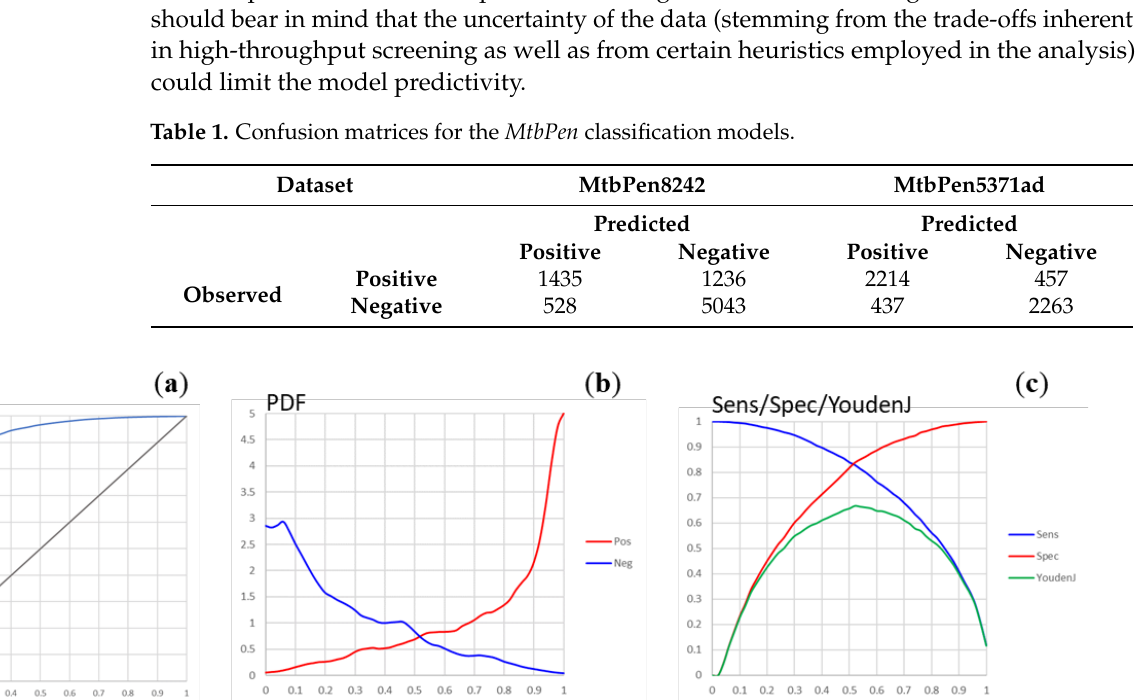
Table 1. Confusion matrices for the MtbPen classification models.